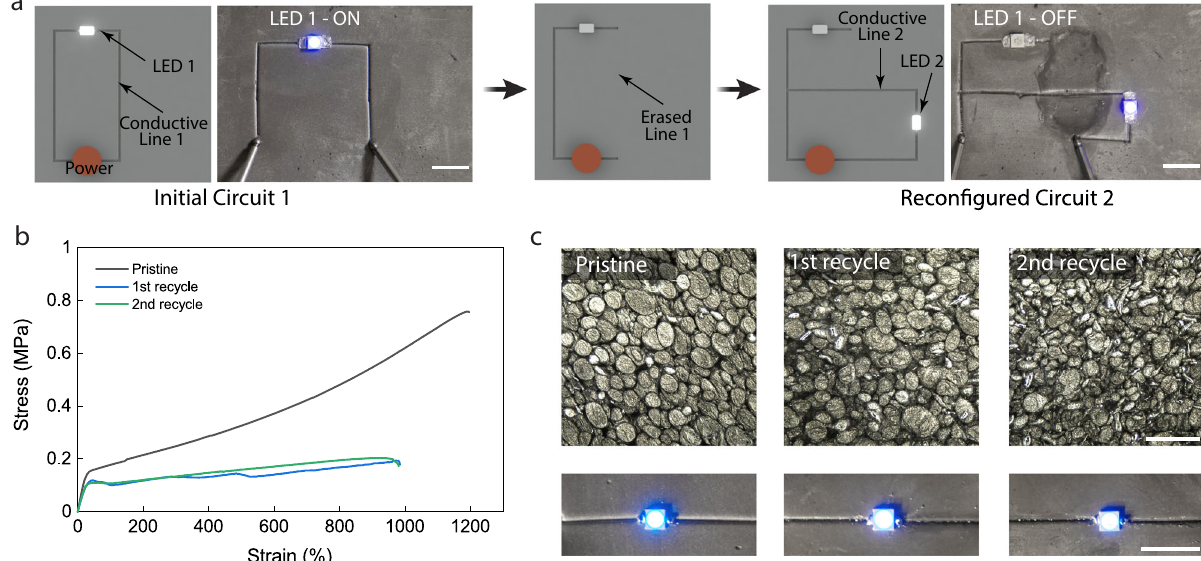
Fig. 5 Recon fi guration and recycling of liquid metal soft composite. a Schematics and photographs showing the recon fi guration process of a conductive trace by solvent erase approach in a composite with ϕ = 60%, δ = 20%, scale bars — 10 mm. b Stress – strain curves of the pristine, and recycled samples showing a higher stress level for the pristine. c Optical micrographs show the change in liquid metal droplet microstructure with recycling and the LEDs show no loss of electrical functionality in a composite with ϕ = 60%, δ = 10% (scale bar for micrographs — 100 μ m and images — 10